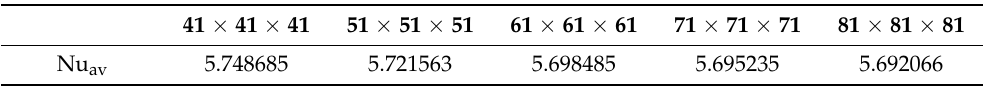
Table 2. Sensitivity to the mesh of the average Nusselt number at different numbers of grids for (Ra = 10 5 , φ = 0.02 and d =